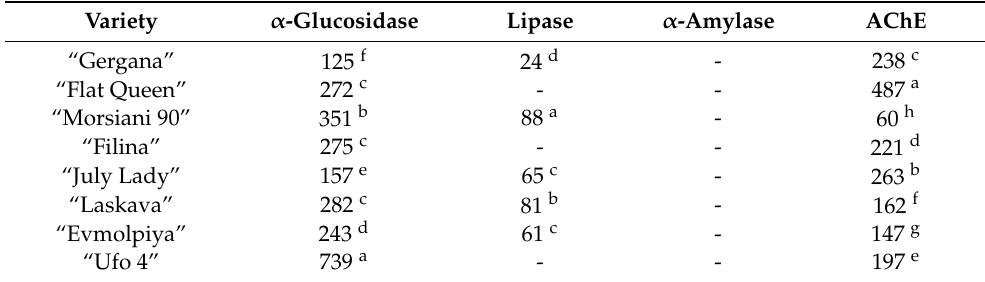
Table 5. Enzyme-inhibitory activities ( α -glucosidase, lipase, α -amylase, and acetylcholinesterase (AChE)) of eight peach varieties’ peel extracts, IC 50 , mg/mL. Variety α -Glucosidase Lipase α -Amylase AChE “Gergana” 125 f 24 d - 238 c “Flat Queen” 272 c - - 487 a “Morsiani 90” 351 b 88 a - 60 h “Filina” 275 c - - 221 d “July Lady” 157 e 65 c - 263 b “Laskava” 282 c 81 b - 162 f “Evmolpiya” 243 d 61 c - 147 g “Ufo 4” 739 a - - 197